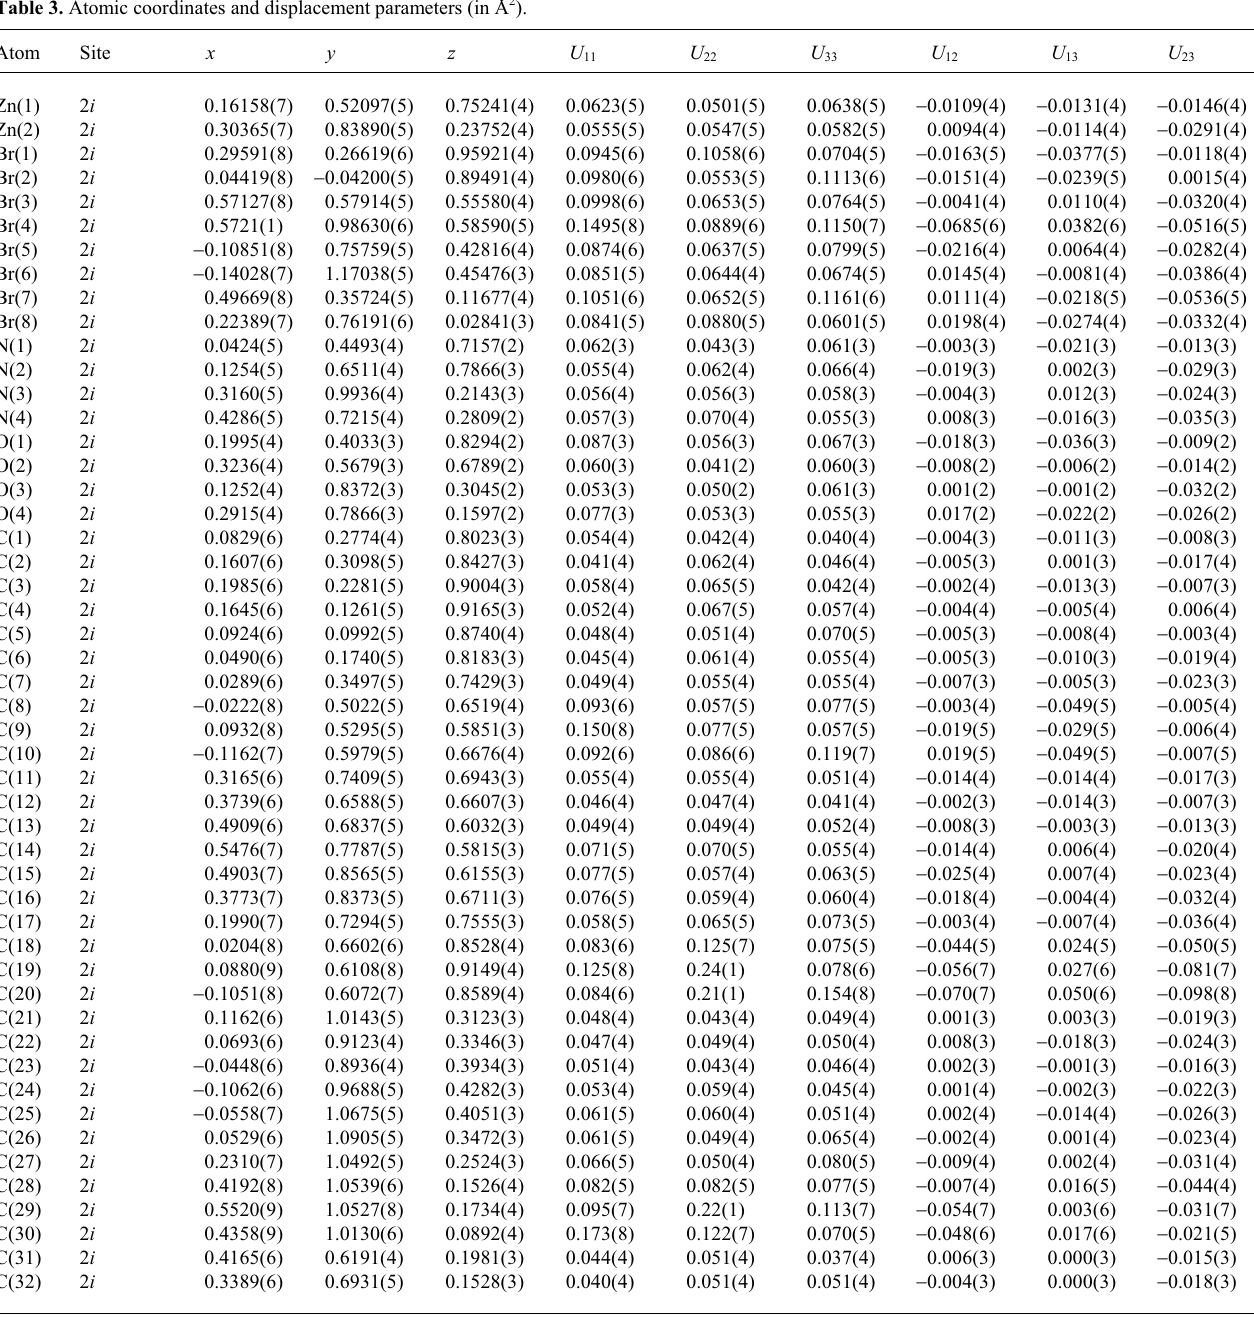
Table 3. Atomic coordinates and displacement parameters (in Å 2